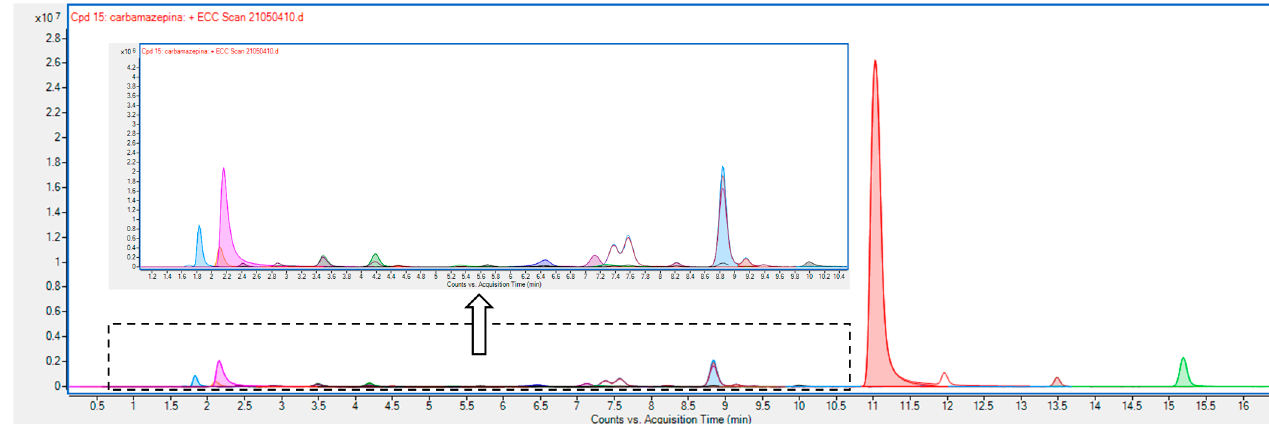
Figure 10. Chromatographic profile of the major compounds detected in the sample of carbamazepine oxidized to pH = 4.0. Experimental conditions: (CBZ) = 50.0 mg/L; (Fe) = 10 mg/L; (H 2 O 2 ) = 15.0 mM; T = 25 °C; (UV) = 150 W.